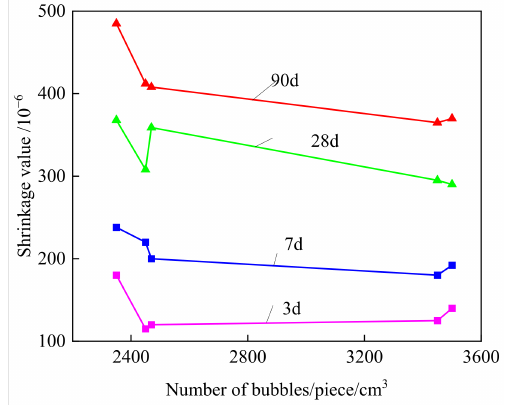
Figure 27. Effect of bubble number on the drying shrinkage of